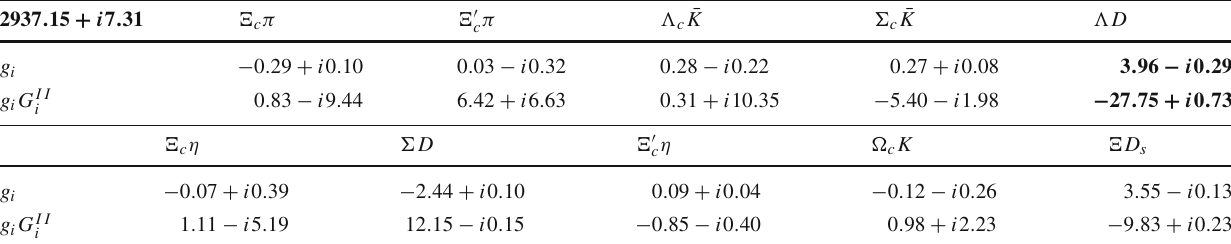
Table 13 The coupling constants to various pseudoscalar-baryon channels and g i G II q max = 700MeV (all units are in